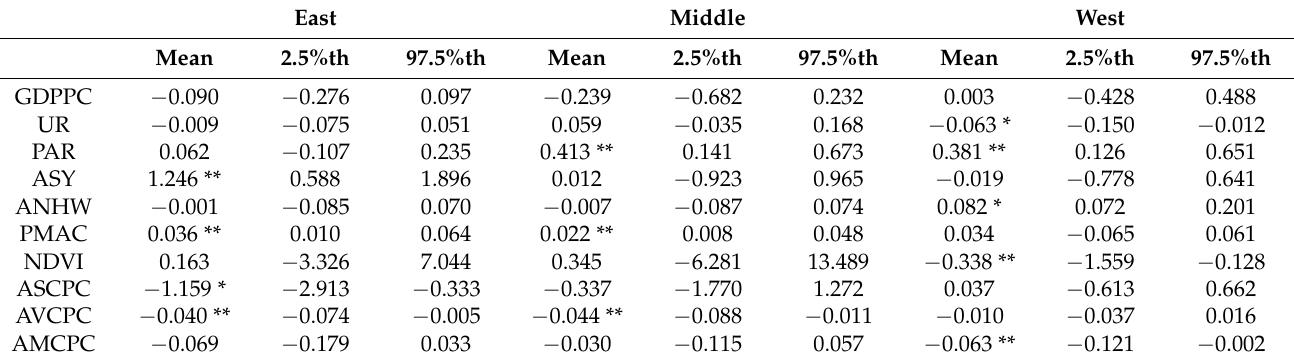
Table 5. The B-LASSO model’s estimated regression coefficients of the 10 influence factors on THEE as a share of GDP (%) at subnational scale, east, middle, and west of the Chinese mainland. East Middle